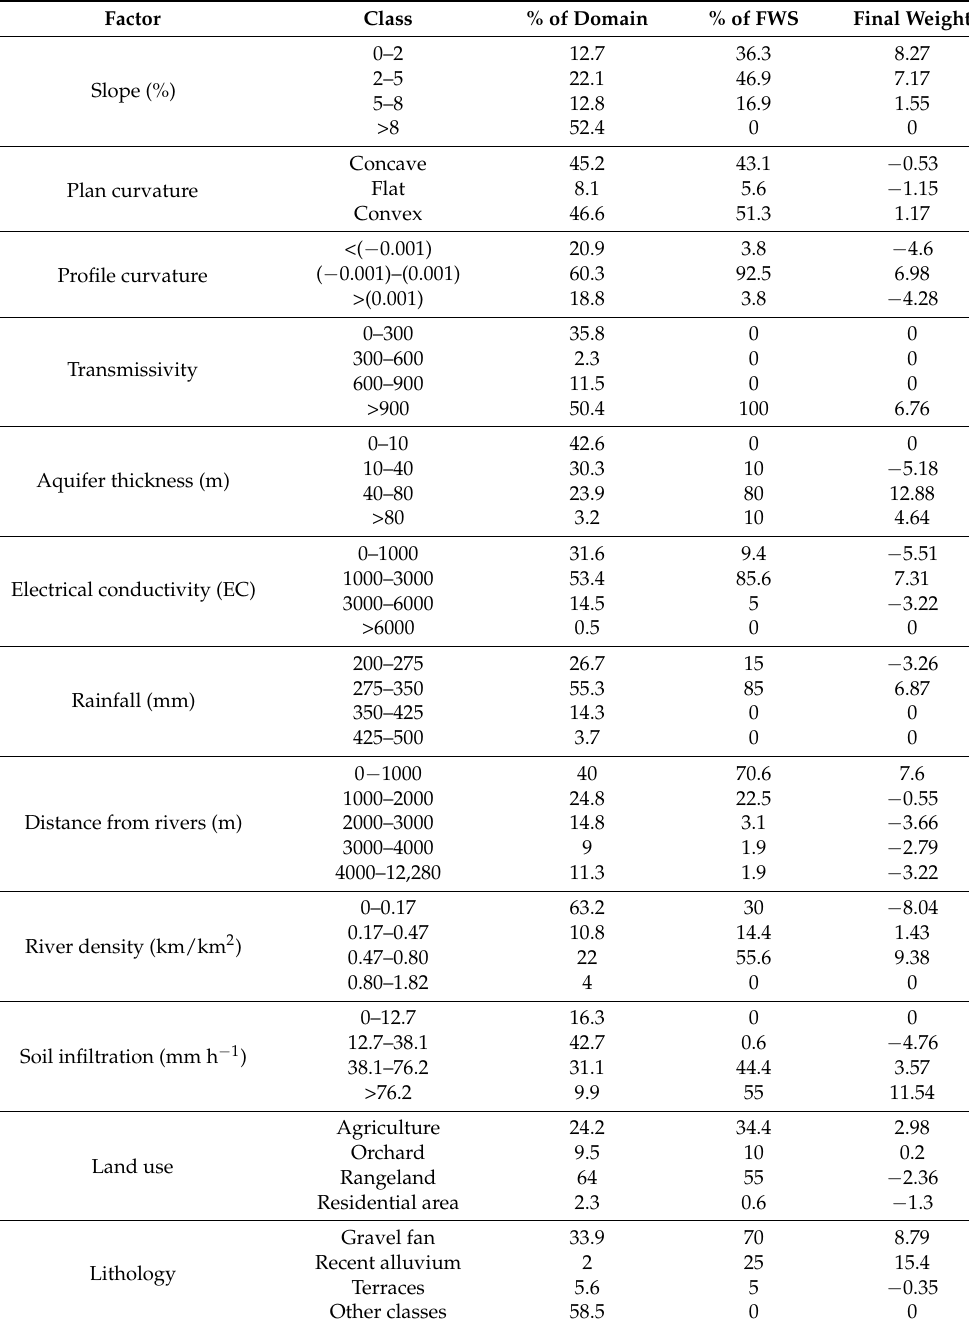
Table 3. The spatial relationship between the conditioning factors and floodwater spreading suitable locations by WoE